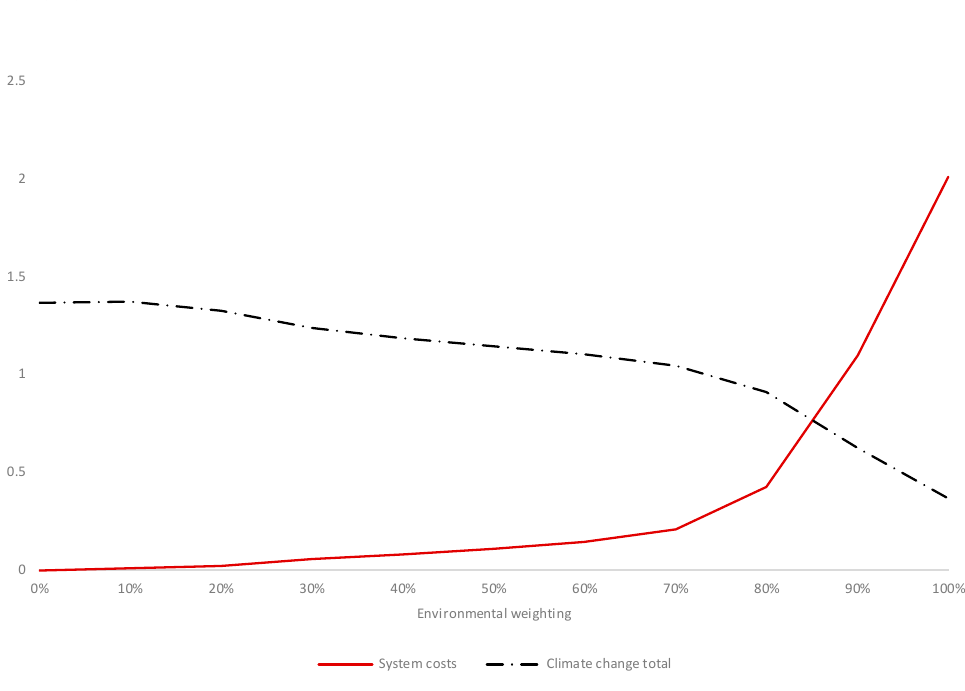
Figure 7. Normalised distance from minimum in the categories system costs and climate change total in dependence of the total environmental weighting compared to costs.